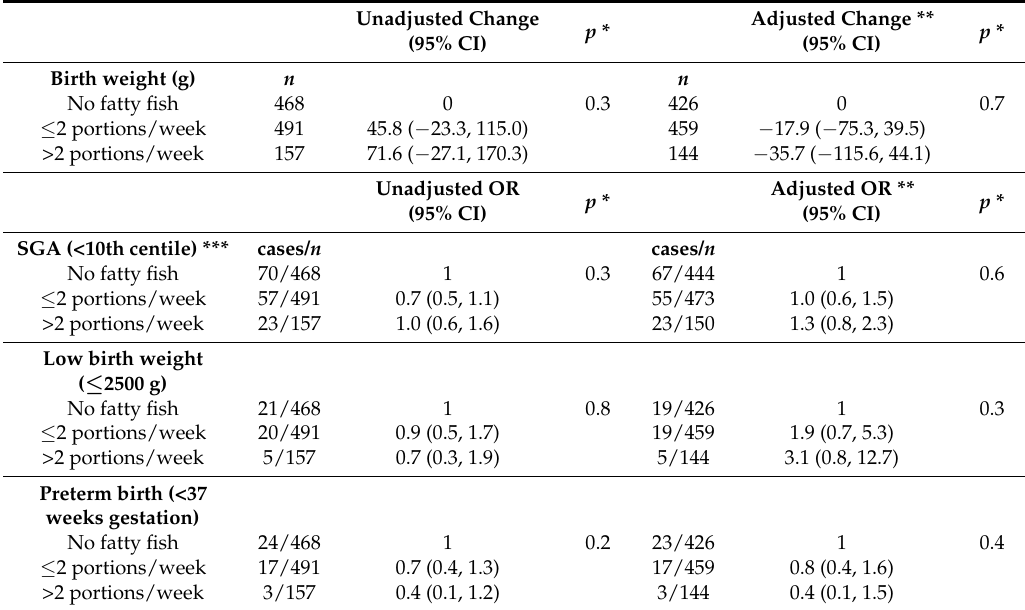
Table 3. The relationship between maternal fatty fish intake 4 weeks before pregnancy and size at birth & preterm